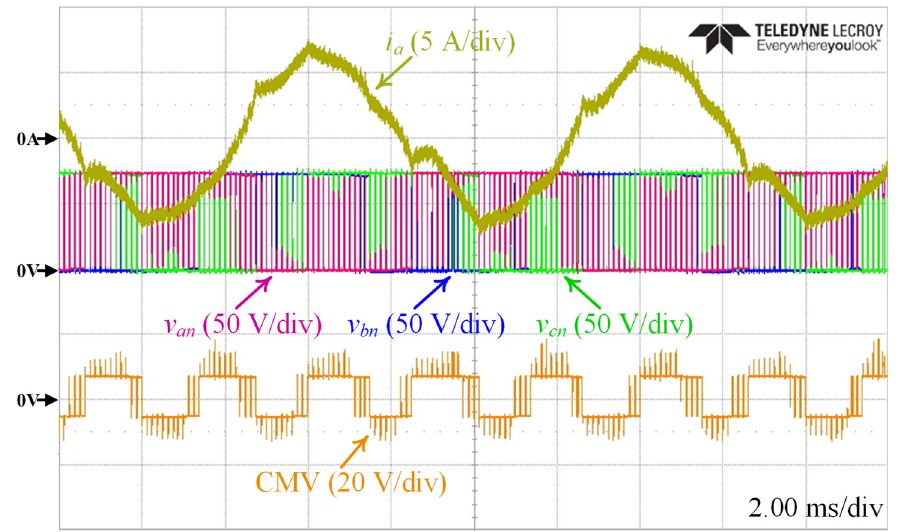
Figure 22. Experimental results of a -phase current, three-phase pole voltage, and CMV at rated load current and rotor speed of 1500 rpm.